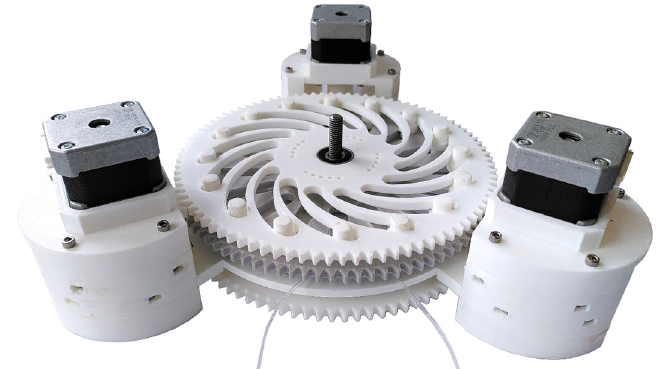
Figure 19. Assembled pump with all gears and motors.